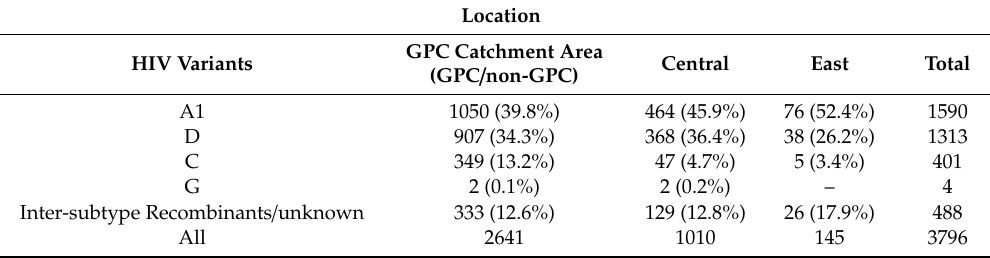
Table 2. Distribution of HIV pol sequences according to